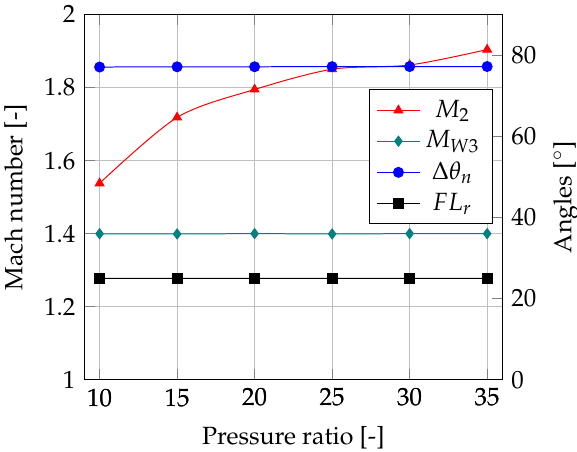
Figure 14. Turbine and flow parameters for the optimal geometric configurations with optimized rotational speed. Pressure ratio versus nozzle and rotor Mach numbers on the left axis; nozzle blade deflection and rotor flare angle on the right